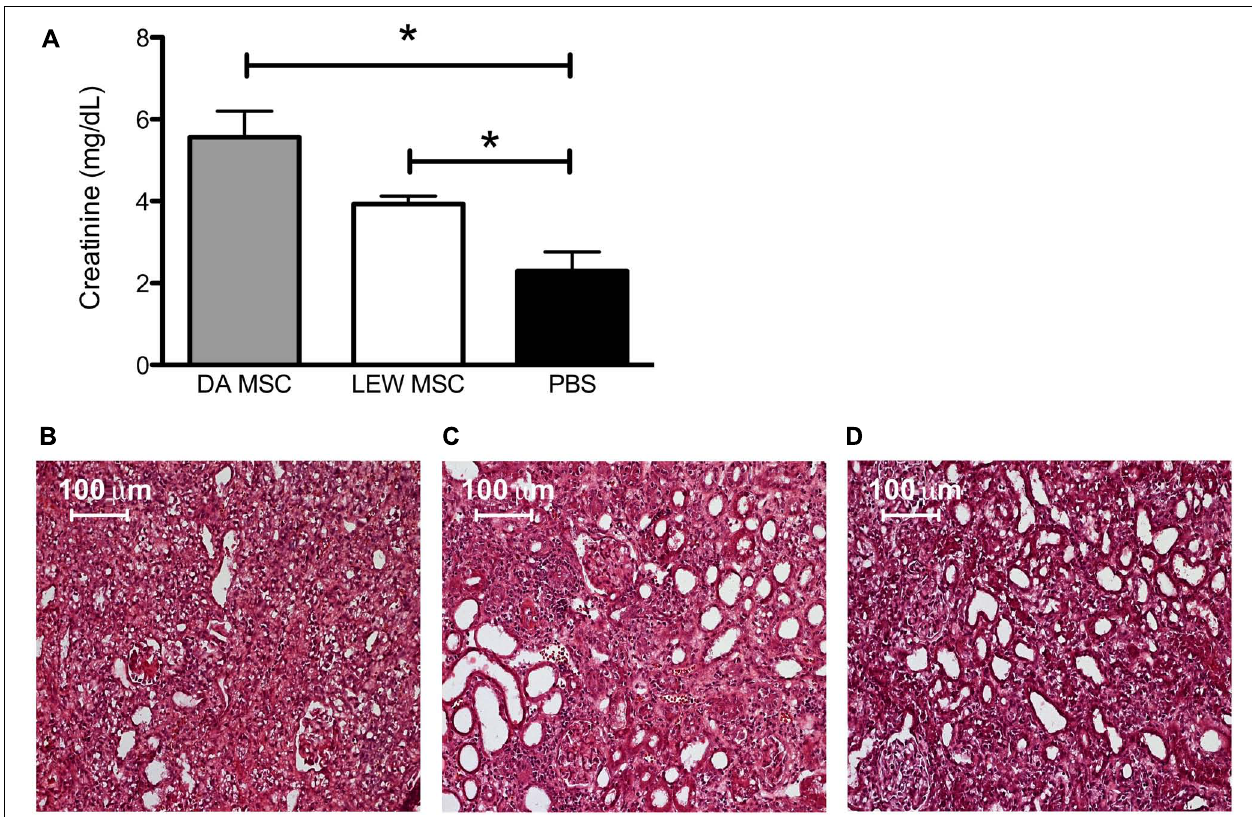
30% sucrose and embedded. Five to eight micron thick sections were stained with Harris’s hematoxylin followed by Eosin to evaluate tissue integrity. Representative images are shown for rats injected 4 days prior to transplant with (B) DA-MSC, (C) LEW-MSC, or (D) PBS. Scale bars represent 100 μ